Question: Express in one sentence what the figure is showing.
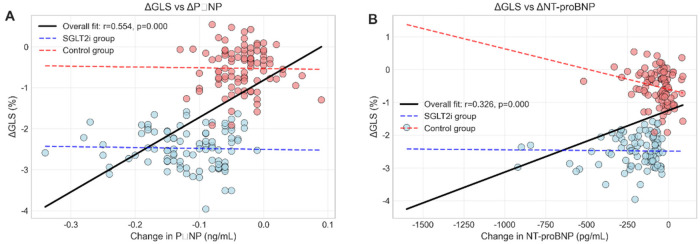
Answer: Correlation between improvement in GLS and reduction in fibrosis markers. (A) Scatter plot of Δ GLS vs. the change in PⅢNP ( Δ PⅢNP). Blue circles: SGLT2i group; red circles: control group. Pearson correlation coefficients (r) and p -values are displayed for each group. (B) Scatter plot of Δ GLS vs. the change in NT-proBNP ( Δ NT-proBNP). Correlation coefficients and p -values are shown for both groups.